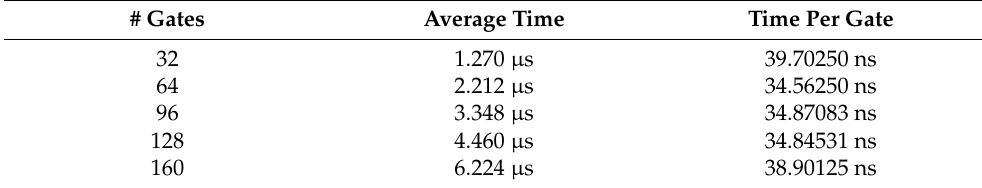
Table 3. Comparison between gate count and processing time per gate for each configuration.